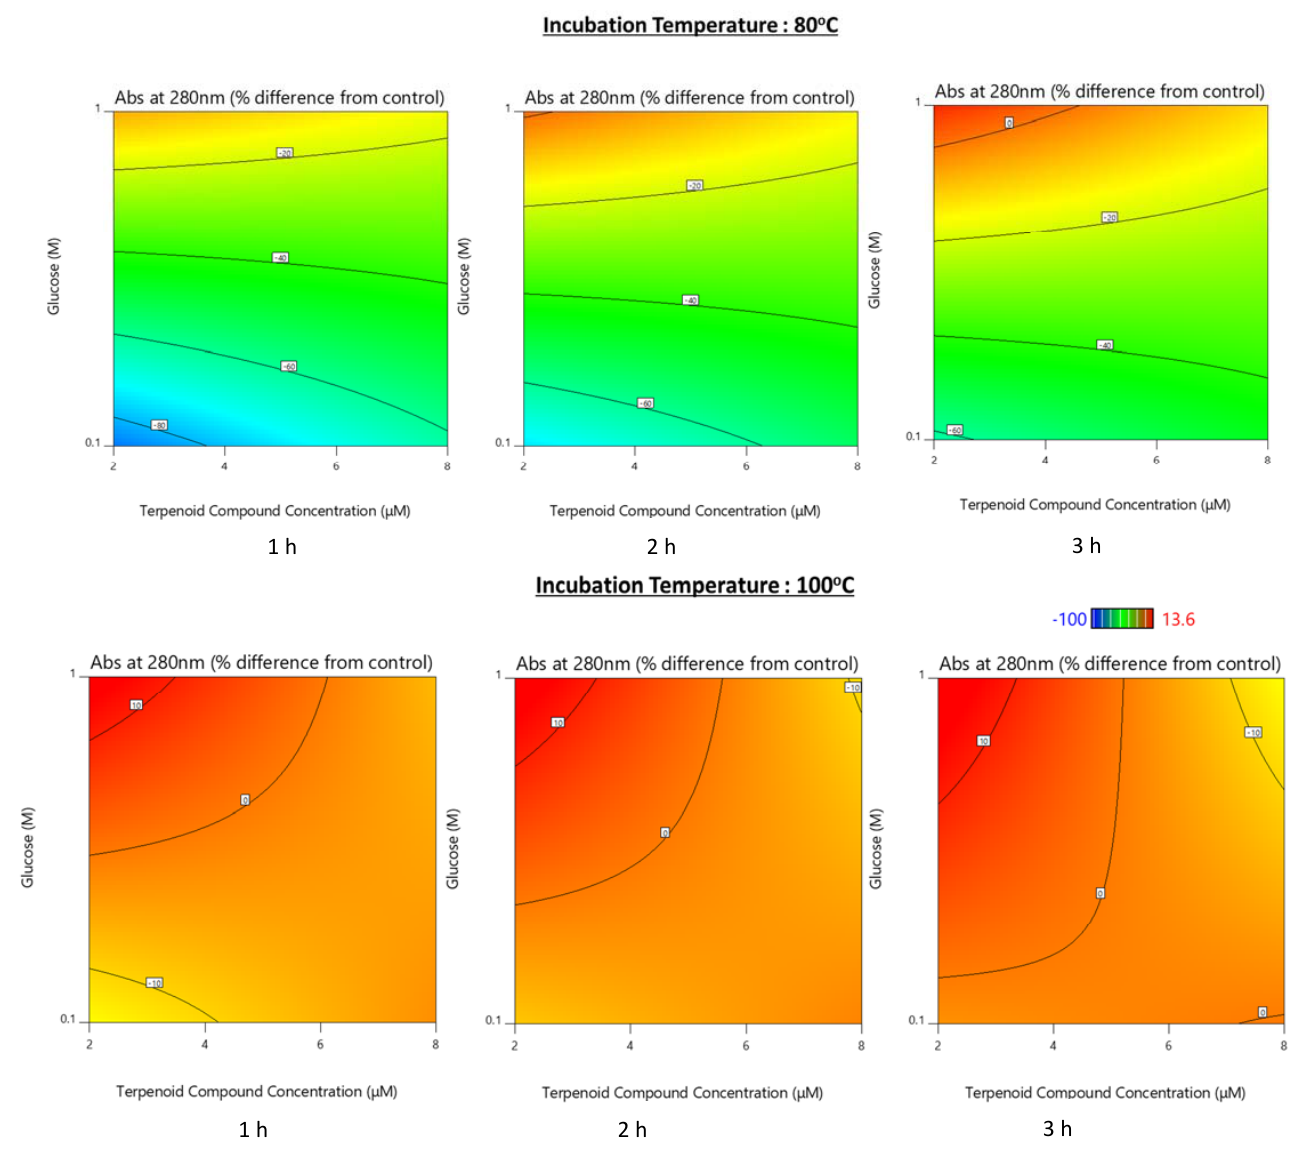
Figure 3. The effect of terpenoid compound concentration and glucose concentration on early glycation products formation (280 nm) expressed as percentage difference from control (no terpenoid compound added) at pH 7.2 and 80 ◦ C and 100 ◦ C. Figures indicate average values of all three terpenoid compounds (linalool, aniseed oil and thymol).